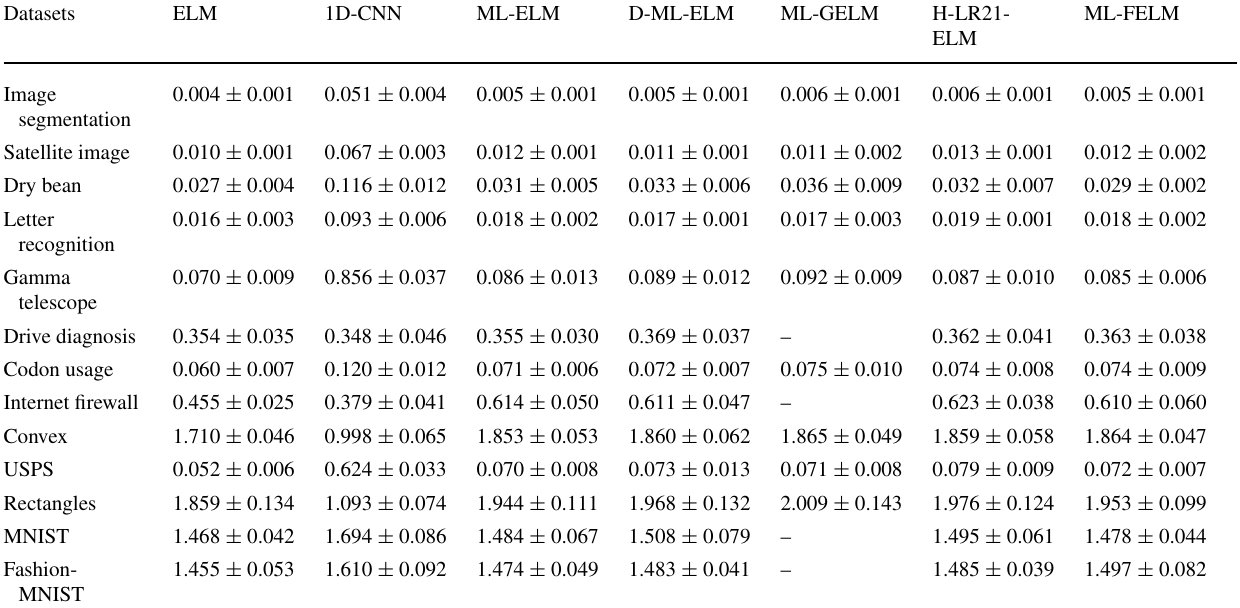
Table 6 The testing time (s) of ELM, 1D-CNN, ML-ELM, D-ML-ELM, ML-GELM, H-LR21-ELM, and ML-FELM Datasets